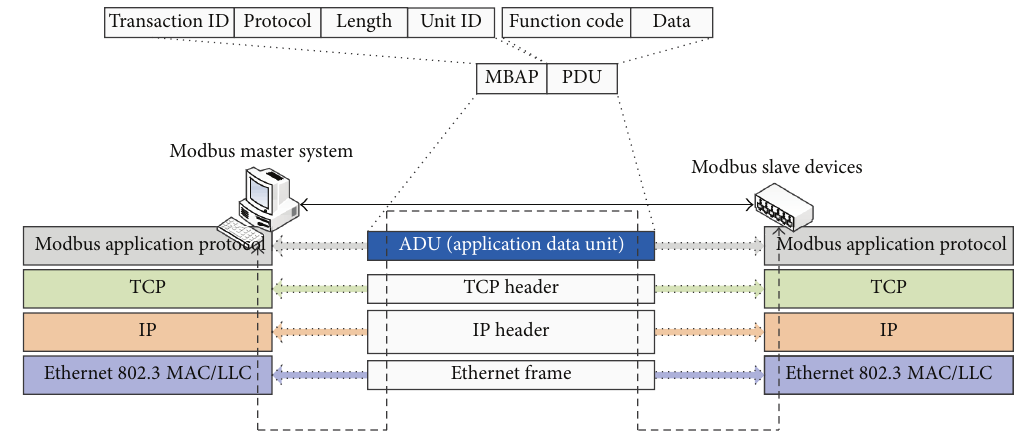
Figure 2: The format of Modbus TCP/IP ADU.